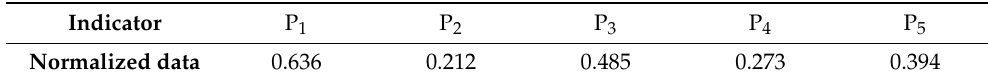
Table A12. Normalized data of personnel risk (P).